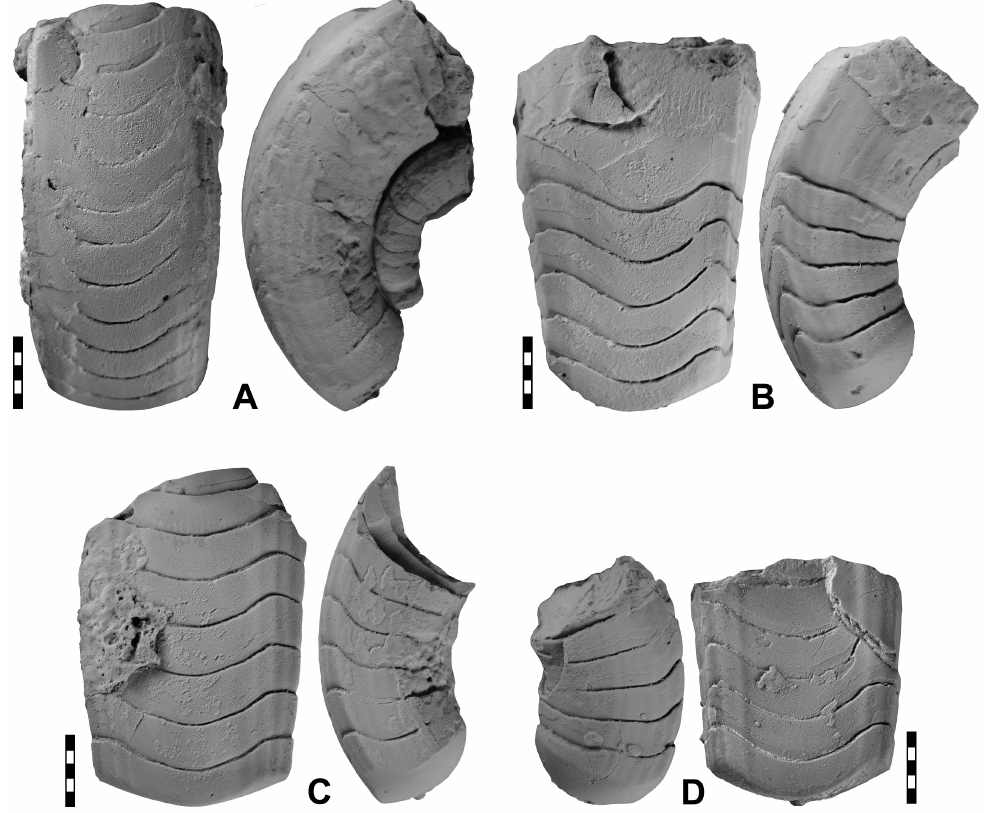
Fig. 6. Stroborineceras insalahensis gen. et sp. nov. from Oued Temertasset (all Korn et al . 2002